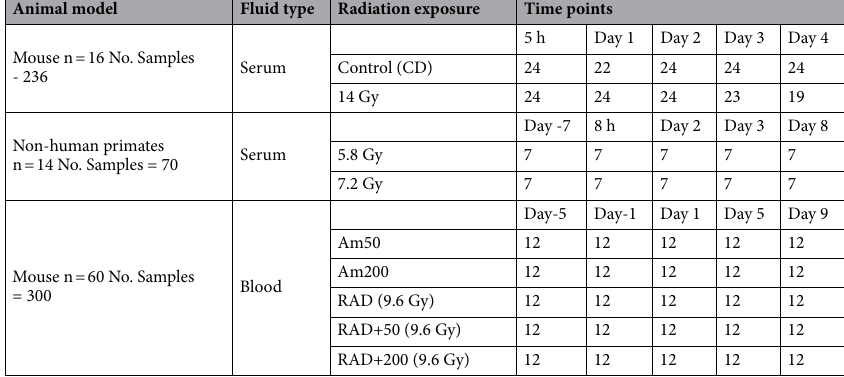
Table 1. Demographics and sample information for the three ARS animal model cohorts